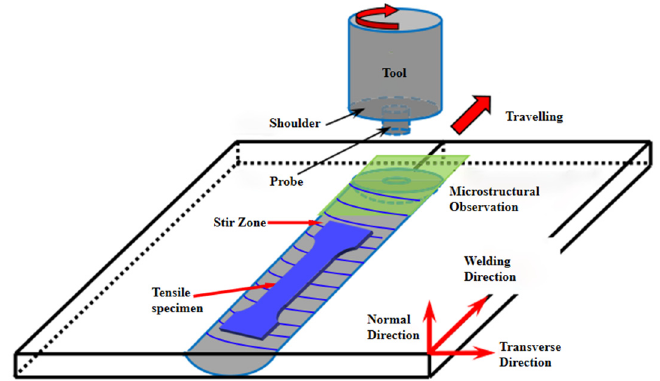
Figure 1. The orientation of the 3D model of the tensile sample.